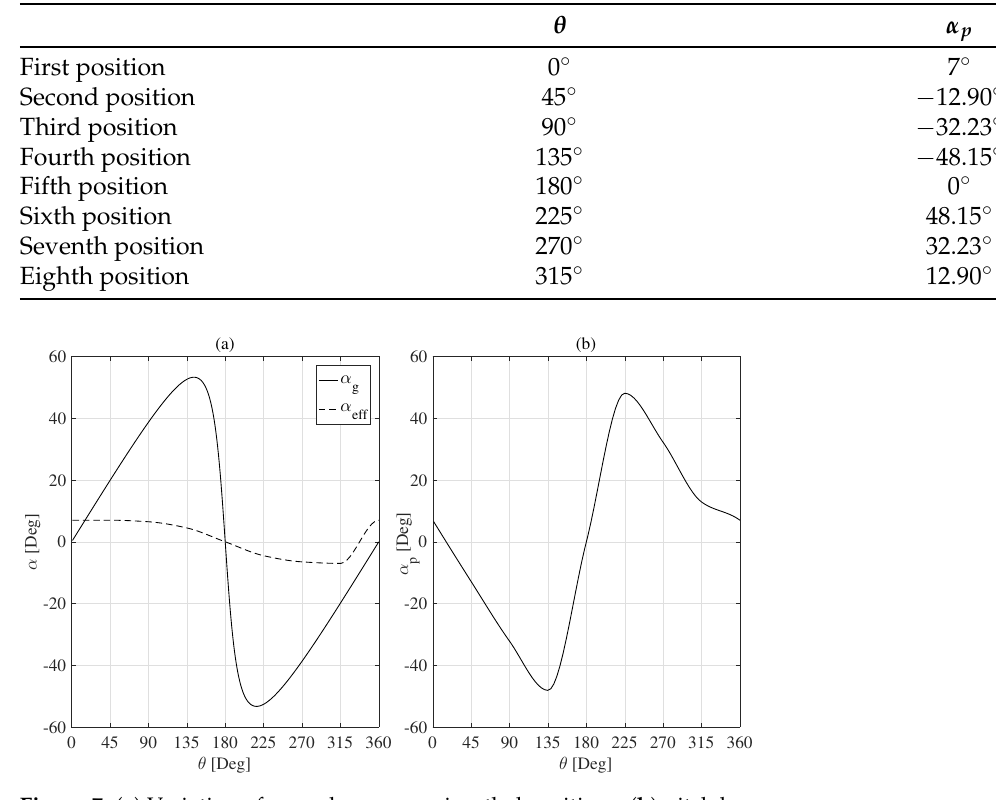
Figure 7. ( a ) Variation of α g and α ef f vs. azimuthal positions; ( b ) pitch law.